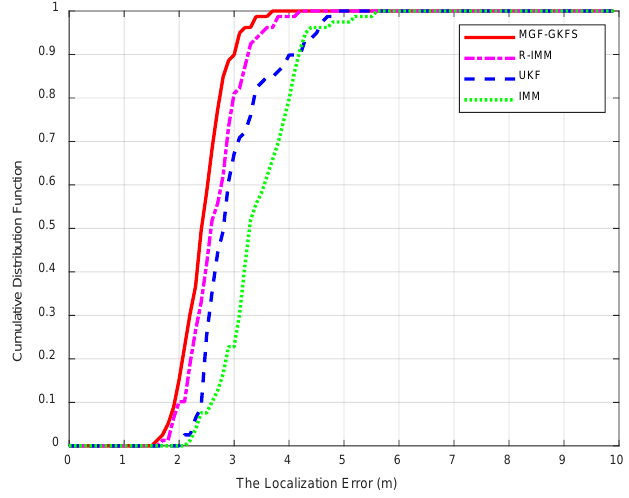
Figure 12. The CDF when NLOS error obeys E ( 3 )